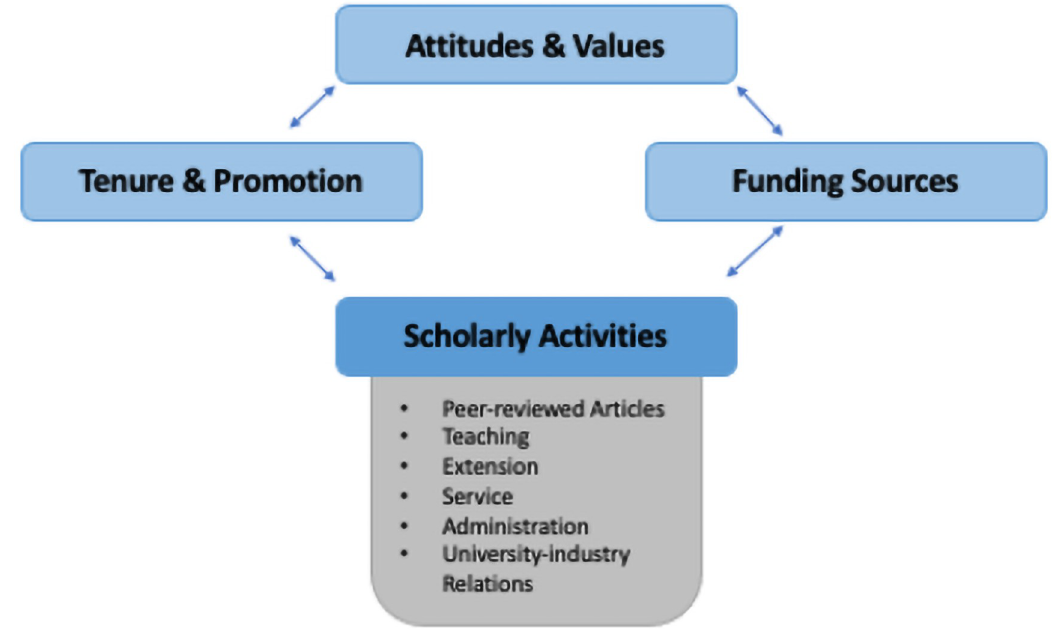
Fig 1. Internal factors shaping scholarly activity. Diagram of internal and external factors shaping scholarly activity: attitudes and values, tenure and promotion, an funding